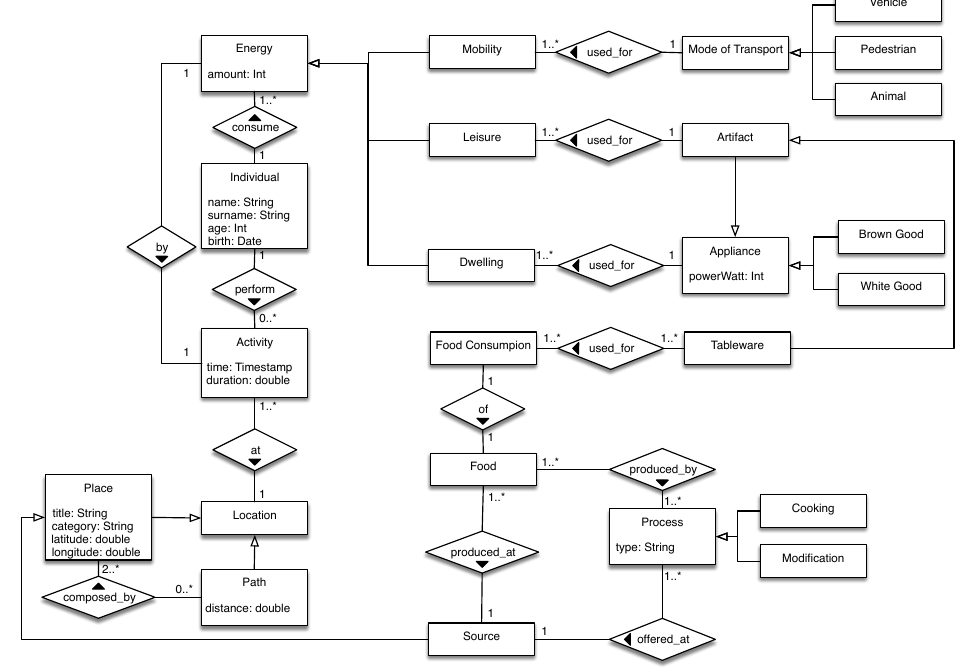
Figure 2. Conceptual data model of energy-consuming